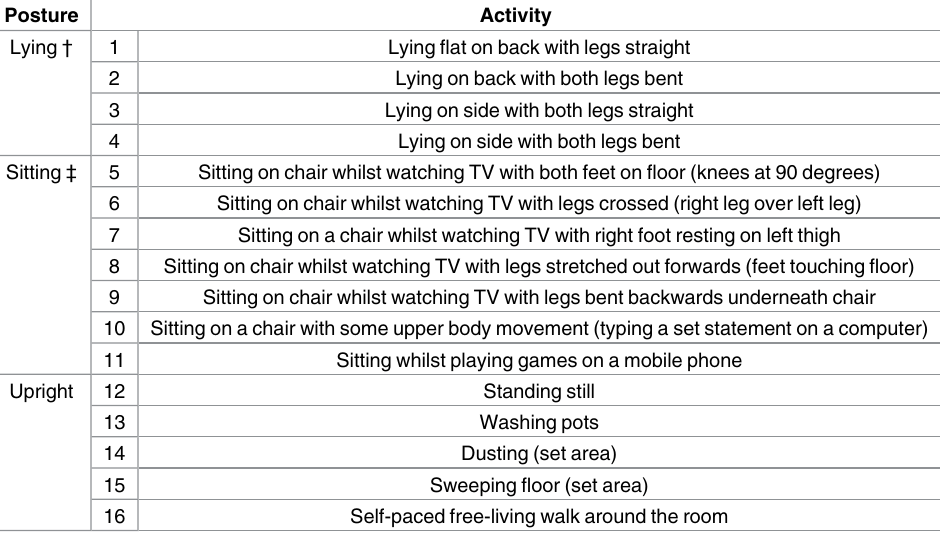
Self-paced free-living walk around the room † During all lying activities, participants were asked to keep their hands straight by their sides ‡ During seated activities 5–9, participants were asked to keep their hands on their thighs The velocity range of the self-paced free-living walk was approximately 3km/h to 4km/h with movement in a forward